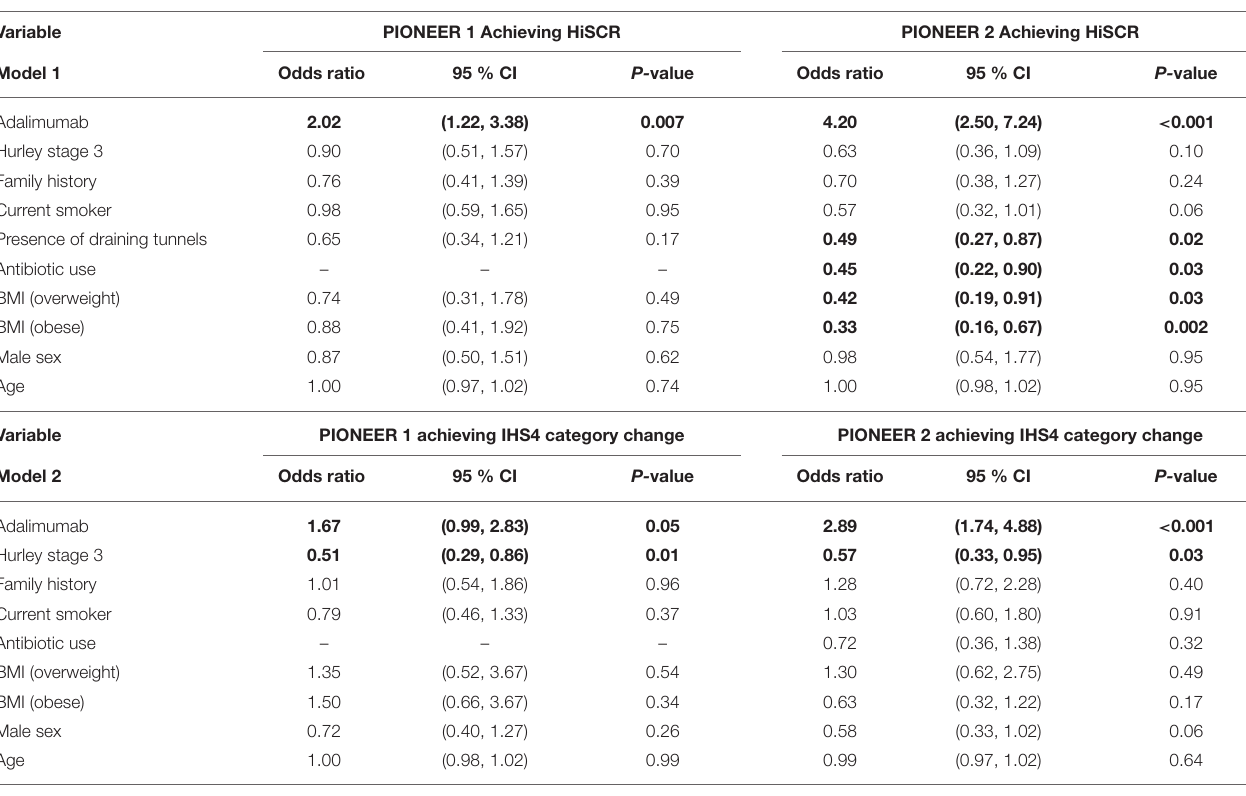
TABLE 3 | Results of logistic regression models of HiSCR achievement (Model 1) and IHS4 category change (Model 2) in patients treated with Adalimumab and Placebo in PIONEER 1 and PIONEER 2.